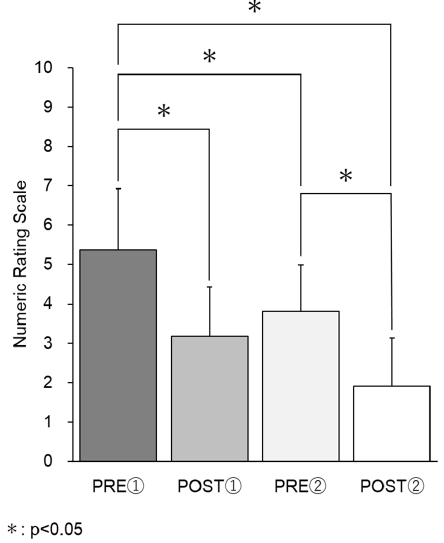
Figure 3. Numeric Rating Scale.